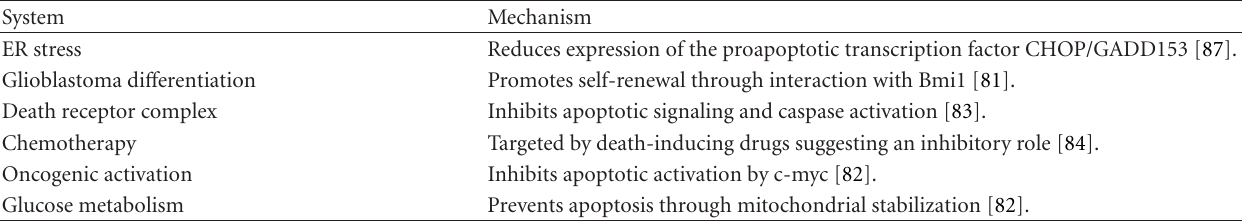
Table 2: Other pro survival roles of GSK-3 β